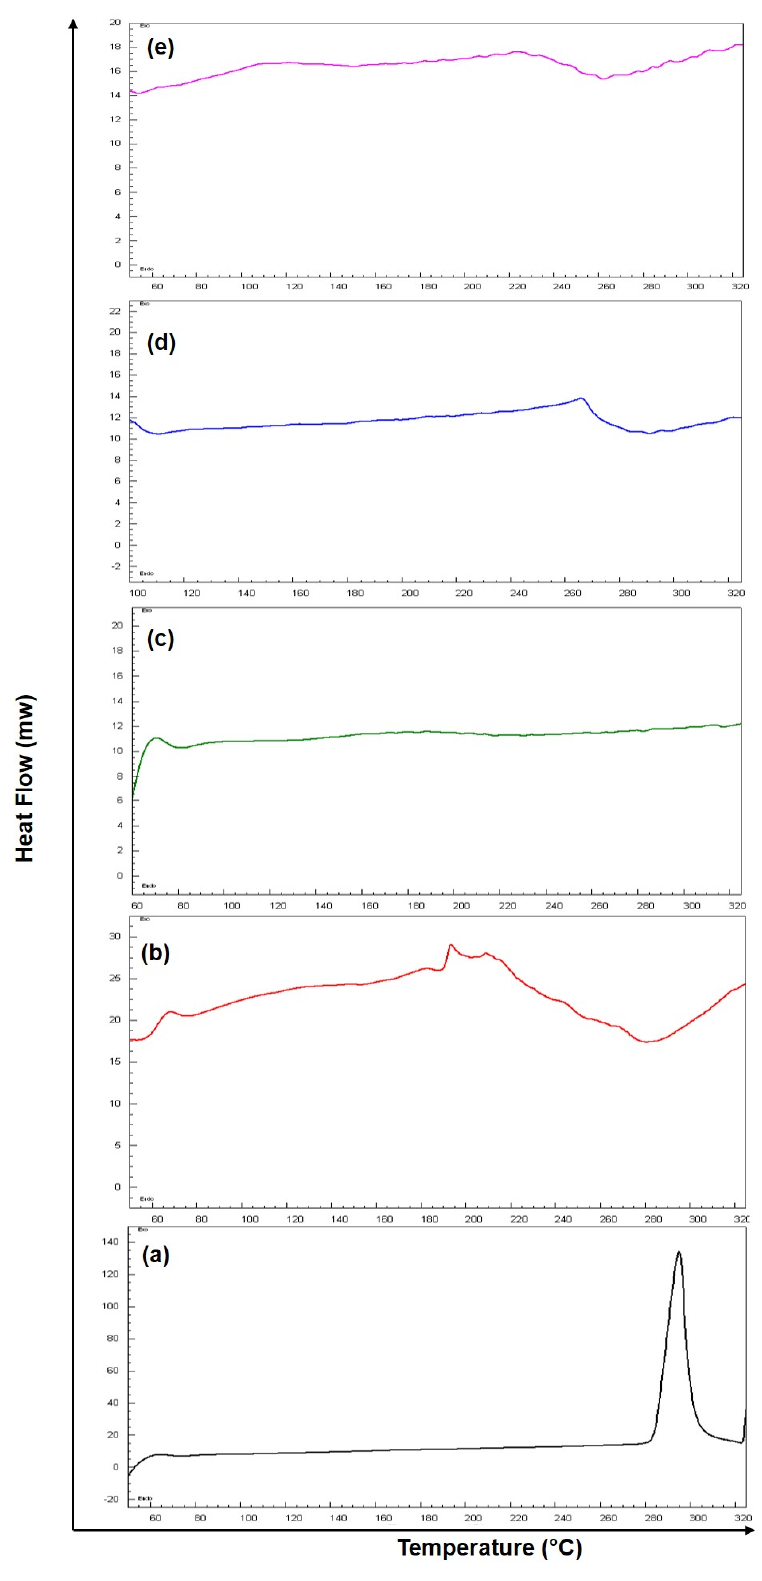
Figure 6. DSC thermogram of pure drug 5-FU ( a ), Eudragit RS-100 (ERS) ( b ), SEMC alone ( c ), 5-FU-loaded SEMC (F2) ( d ) and 5-FU-loaded ERS-coated SEMC (F2-ERS) ( e ).